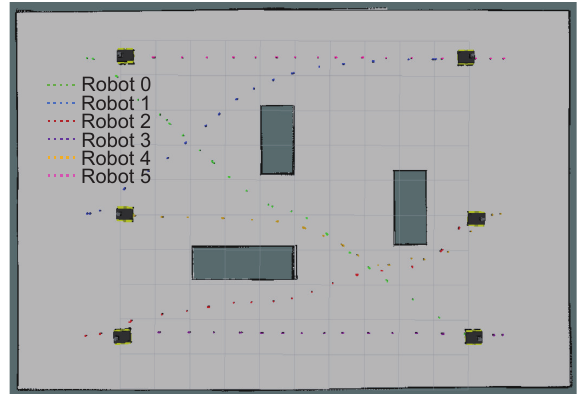
Fig. 15 Planned robot trajectories obtained using the proposed D-MPCC method.